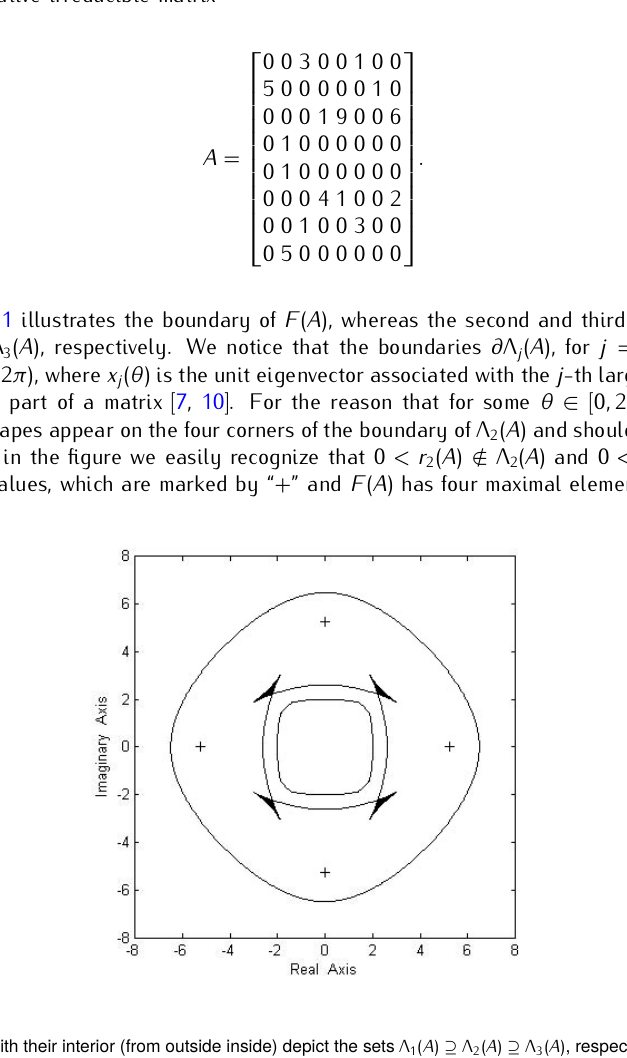
Λ 1 ( A ) ⊇ Λ 2 ( A ) ⊇ Λ 3 ( A ) ,